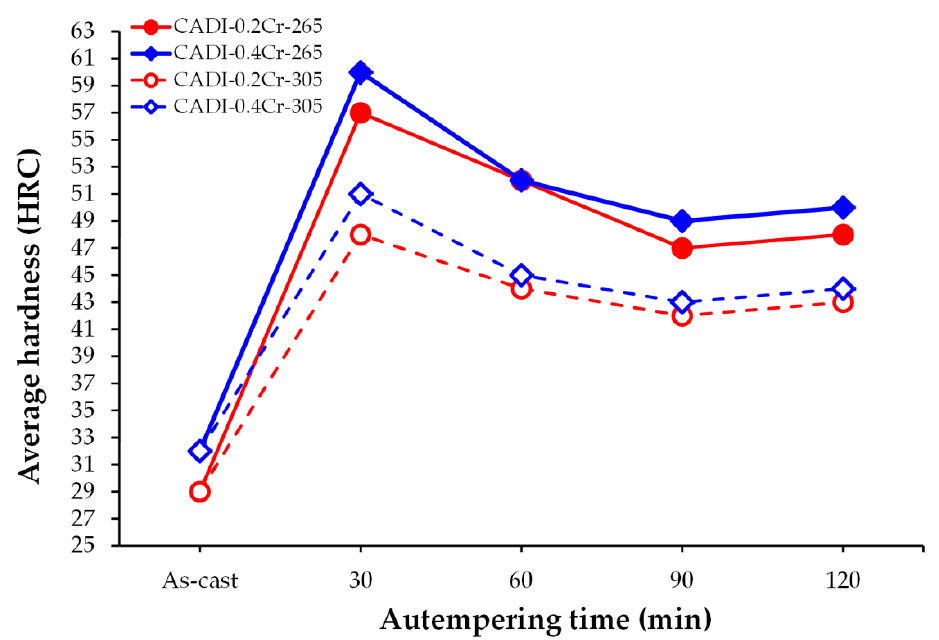
Figure 12. Effect of time and austempering temperature on Rockwell C hardness for CADIs cam-shaft.